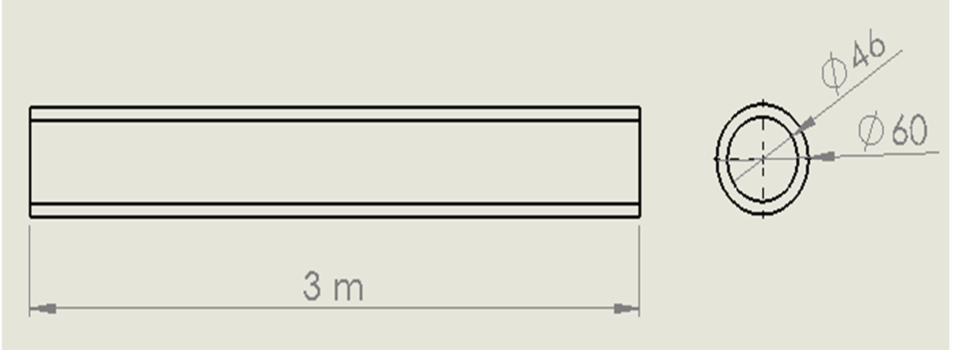
Figure 2. Pipe dimensions used in the FEM simulation and analysis.